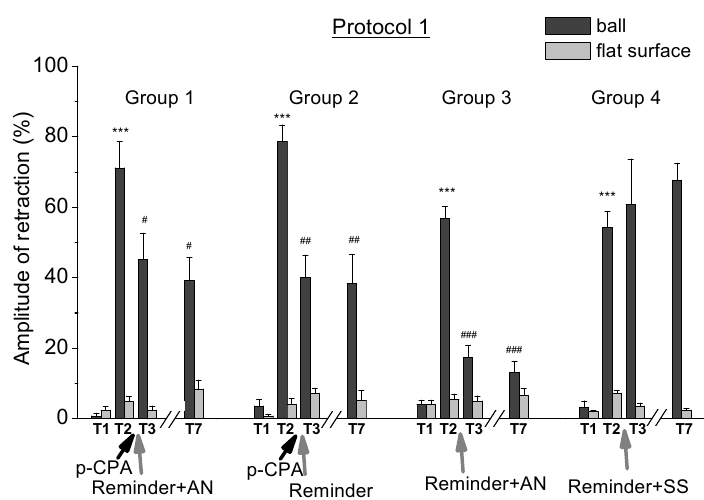
Figure 2. The level of the defensive response (the amplitude of the response of ommatophores withdrawal) of snails in two contexts, on the ball and flat surface for the experimental series 1 (protocol 1; Groups 1, 2, 3 and 4). T1—initial testing before the beginning of training, T2—testing 2 days (after 1 day of rest) after elaboration of conditioned reflex (learning), T3–T7—testing of animals after the injections of PCPA, AN and a reminder on the 4th–8th day after areminder (see Figure 1). Arrows indicate: PCPA—time of injection of PCPA (3 days beforethe reminder and injection of AN), Reminder—time of reminder, AN—time of injection of AN. Asterisks and hash signs indicate significant di ff erence of the amplitude of response of ommatophores withdrawal in responses to T3–T7 vs. the amplitude of the response of ommatophores withdrawal in responses to T2 by a paired t -test ( # ) equal to p < 0.05; ( ## ) equal to p <0.01; ( ### ) equal to p <0.001 and T2 vs. amplitude of response of